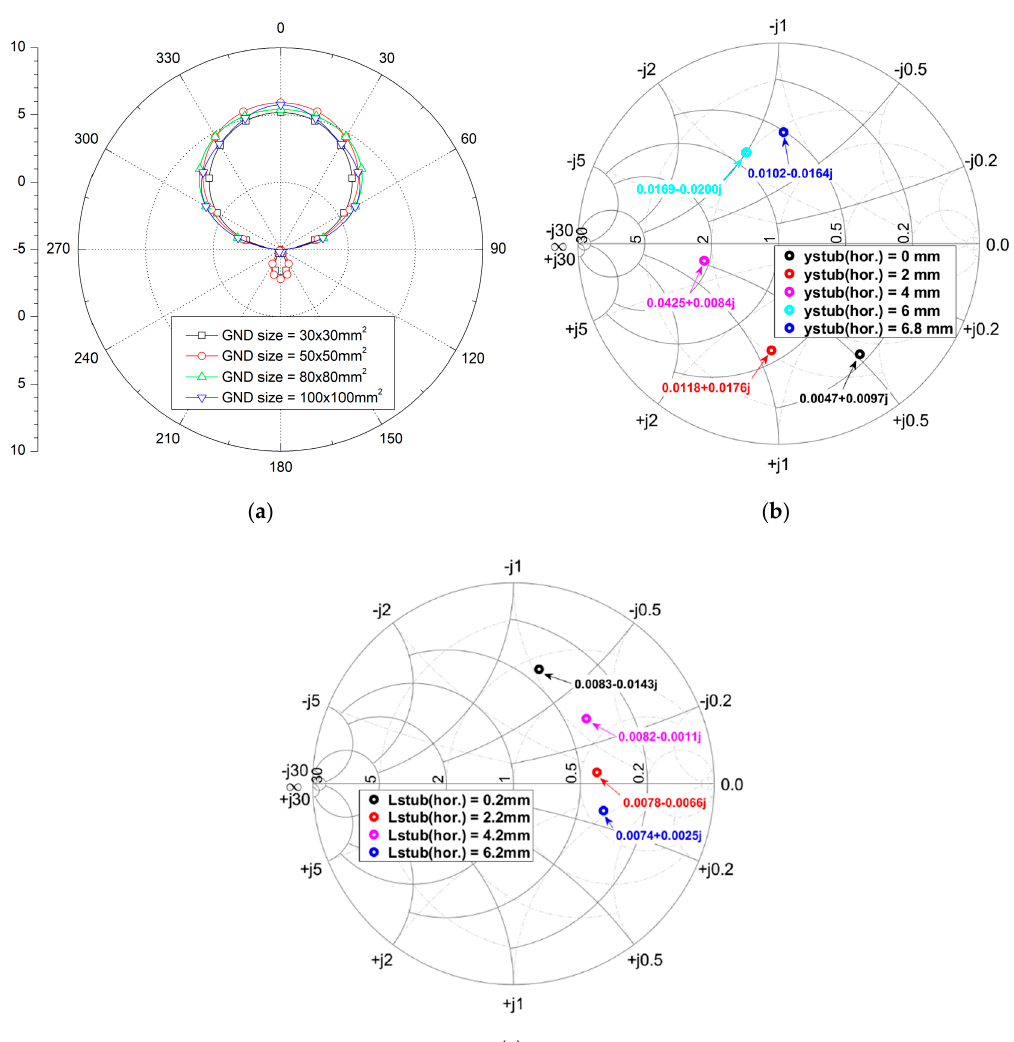
Figure 4. Simulation for ( a ) the radiation patterns on the xz-plane according to different ground plane sizes, and the smith chart impedance matching using the ( b ) ystub (horizontal) and ( c ) Lstub (horizontal) of the feed network, referring to Figure 2 (c), at 5.8GHz.